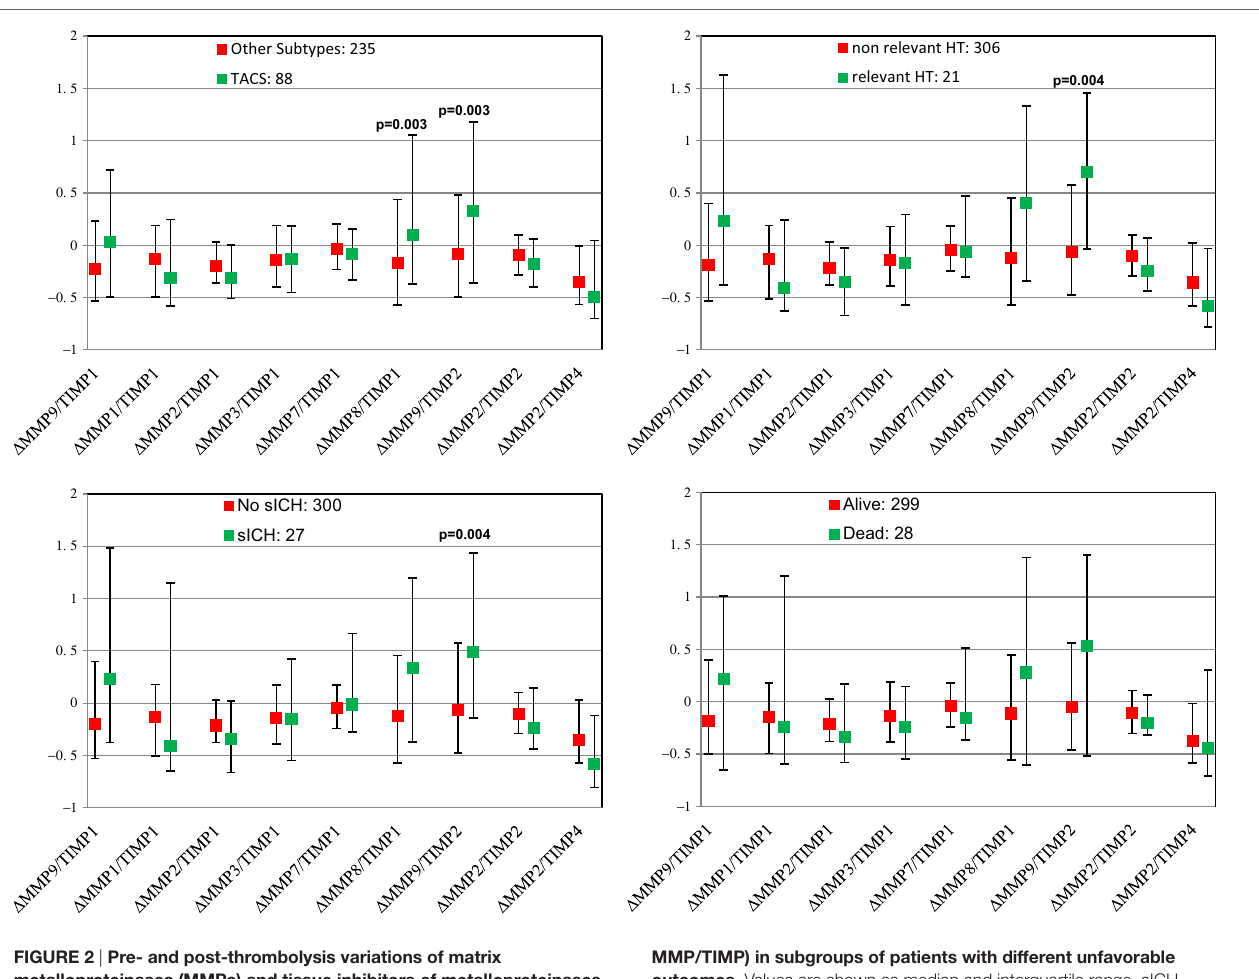
FigUre 2 | Pre- and post-thrombolysis variations of matrix MMP/TiMP) in subgroups of patients with different unfavorable metalloproteinases (MMPs) and tissue inhibitors of metalloproteinases outcomes . Values are shown as median and interquartile range. sICH indicates symptomatic intracerebral hemorrhage. (TiMPs) ratio ( Δ = [24 h MMP/TiMP − baseline MMP/TiMP]/baseline TaBle 2 | effect of delta MMPs/TiMPs ratio on sich, relevant hT, death, and Tacs adjusting for major determinants. MMP/TiMP sich a p relevant hT a Or (95% ci)